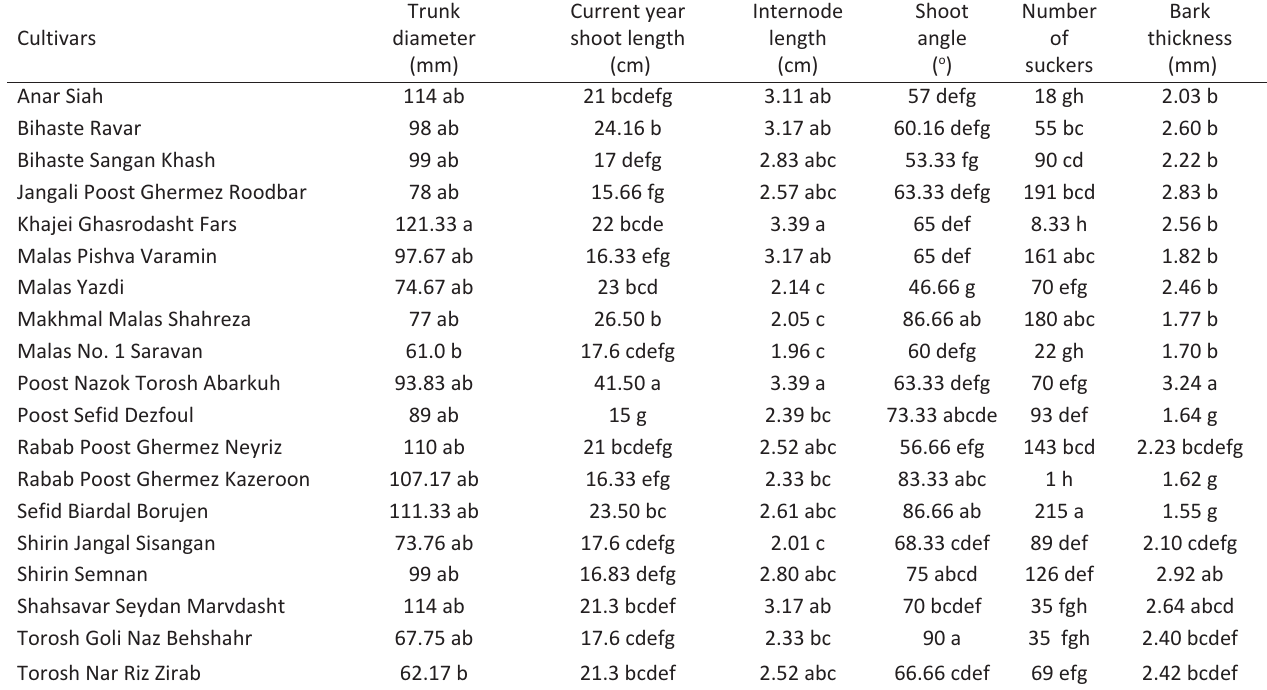
Table 2 ­ Vegetative tree characteristics of the pomegranate cultivars used in the experiment